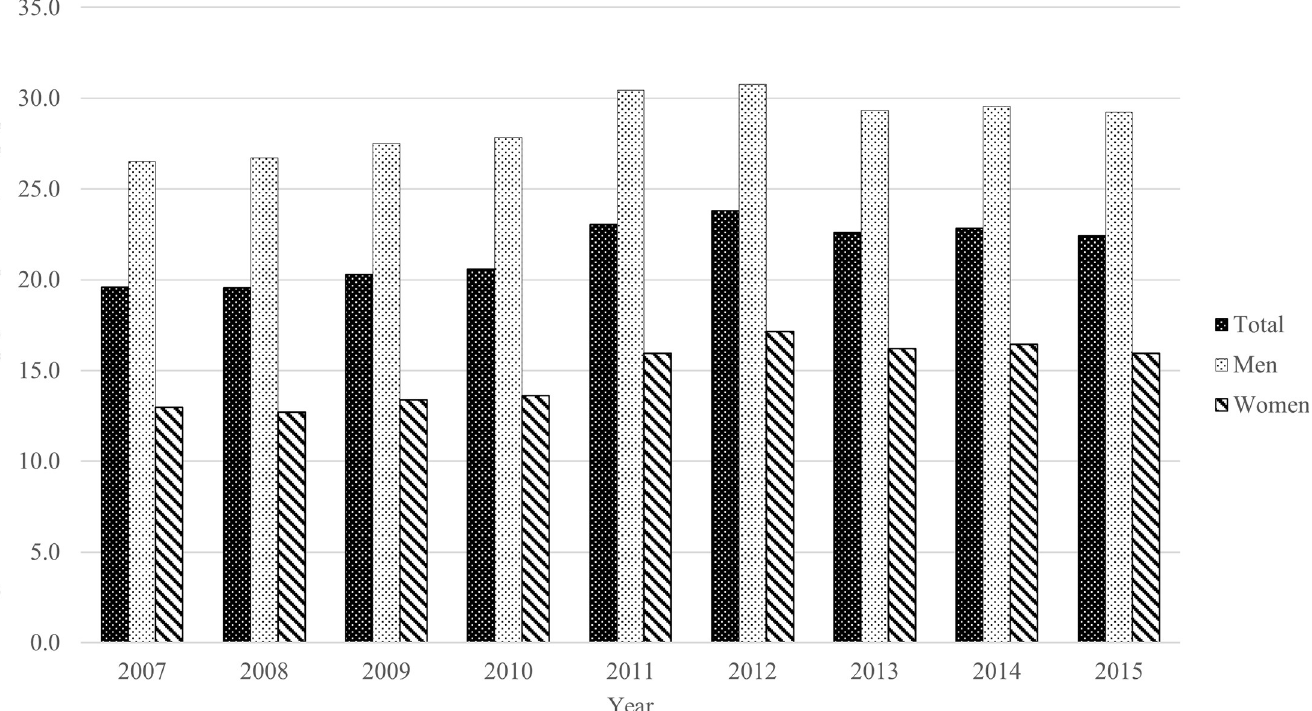
Fig 2. Age-/sex-standardized percutaneous transthoracic needle biopsy rates among the Korean population.